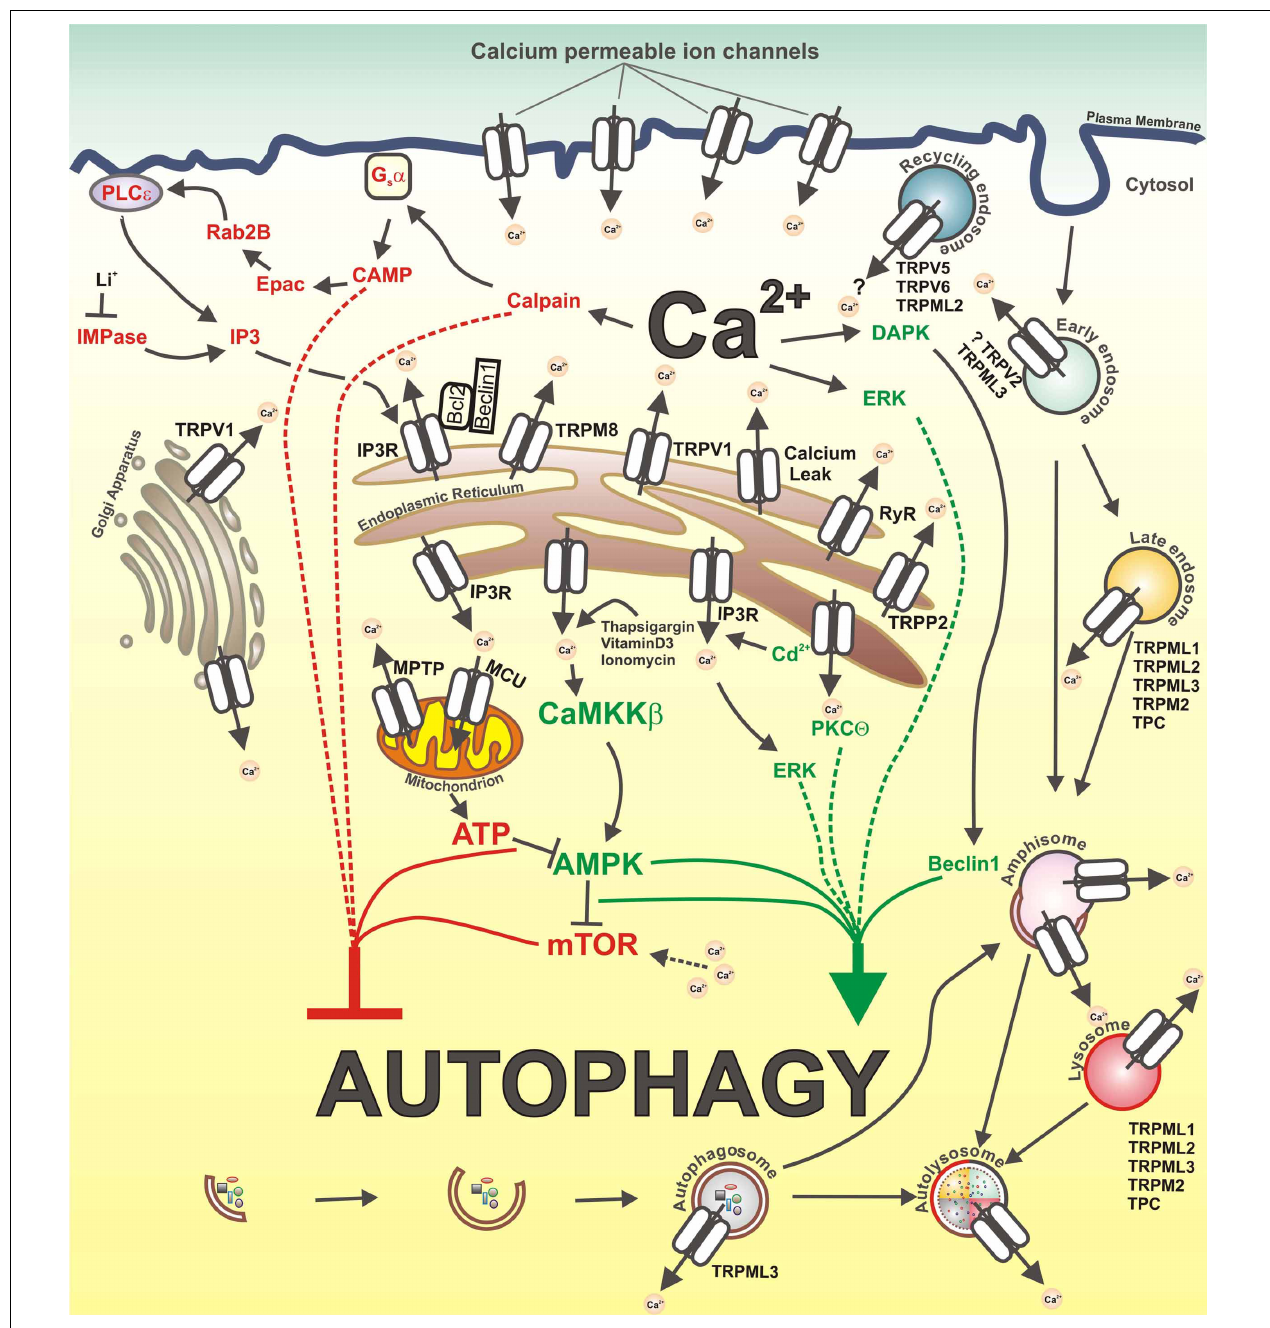
and subsequent ERK activation. In contrast, constitutive IP3R mediated Ca 2 + release to mitochondria maintains ATP production and AMPK inhibition, thereby suppressing autophagy. The inhibition of IMPase by Li + causes a decrease in IP3 levels and autophagy induction. Further, IP3R-dependent Ca 2 + release from the ER as well as amino acids-induced increase in [Ca 2 + ] cyt maintain an elevated mTORC1 activity, thus inhibiting autophagy. In addition, IP3R represses autophagy through Bcl-2-mediated binding of Beclin1. Also, increased Ca 2 + influx through L-type calcium channels on the plasma membrane activates calpains and consequently Gsalpha/Adenylyl cyclase/cAMP/Epac/Rap2B/PLC- ε pathway which negatively regulates autophagy by promoting IP3 production, IP3R activation and Ca 2 +